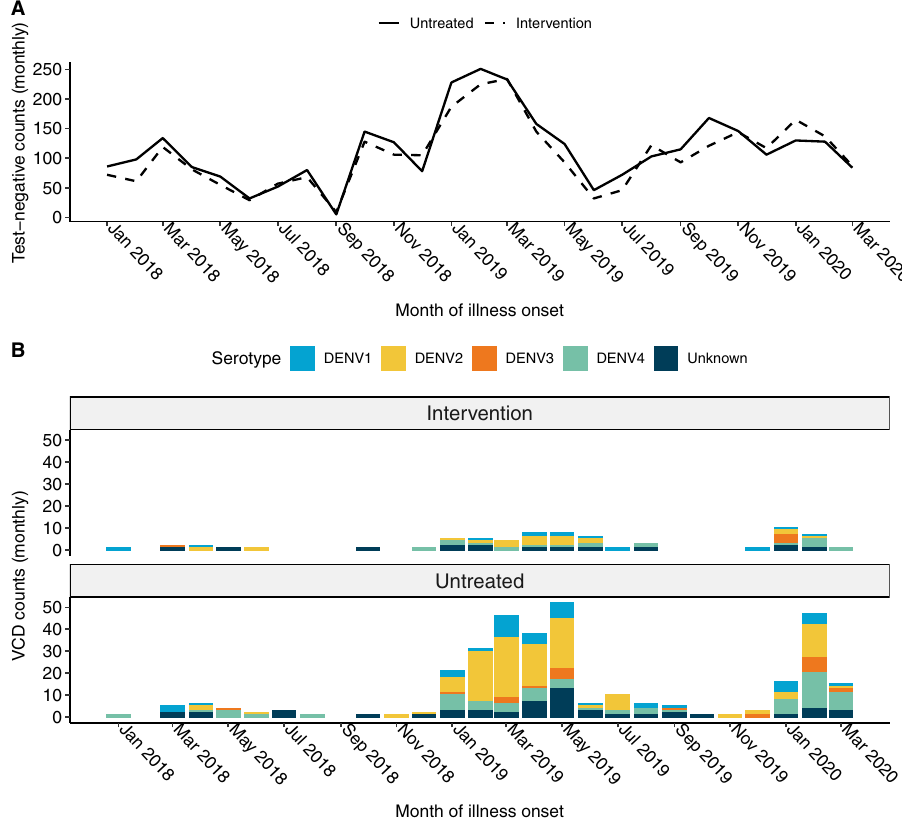
Figure 1. Time series plot for illness onset among ( A ) test-negative controls and ( B ) virologically-confirmed dengue cases included in the primary analysis of the AWED trial in Yogyakarta, Indonesia from January 2018 until March 2020, by intervention arm. No dengue cases were enrolled in September 2018 and, in accordance with the trial protocol 26 , the test-negatives enrolled during that month were excluded from the analysis